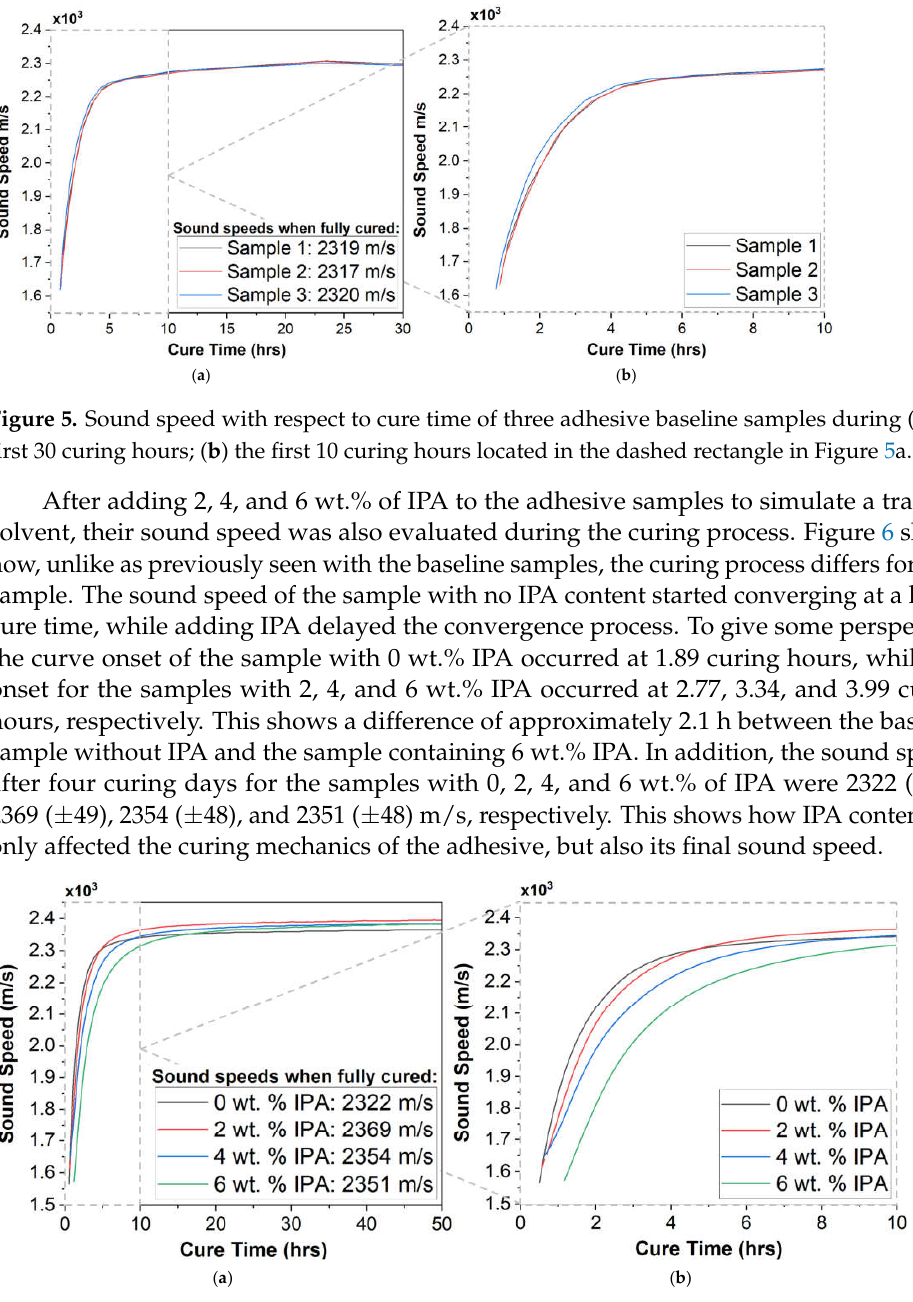
Figure 6. Sound speed with respect to cure time of adhesive samples containing 0, 2, 4, and 6 wt.% of IPA during ( a ) the first 30 curing hours; ( b ) the first 10 curing hours located in the dashed rectangle in Figure 6a.